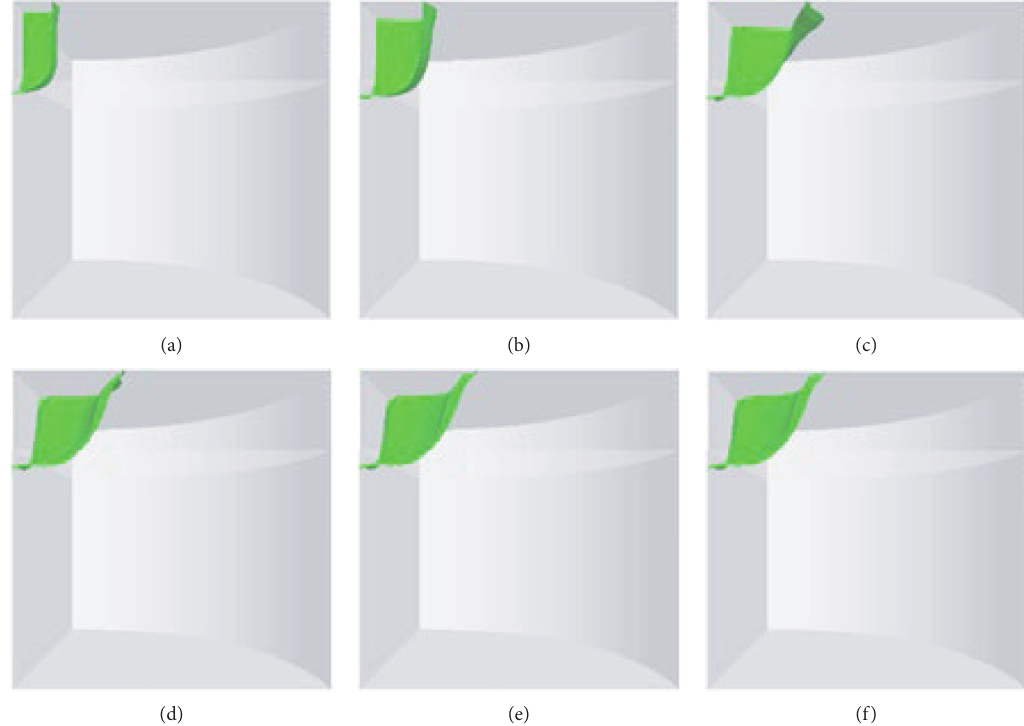
Figure 15: The development of rock mass fracture zone in head-up view: (a) 0.5 ms; (b) 0.8 ms; (c) 1.5ms; (d) 2.0ms; (e) 2.5ms; (f)